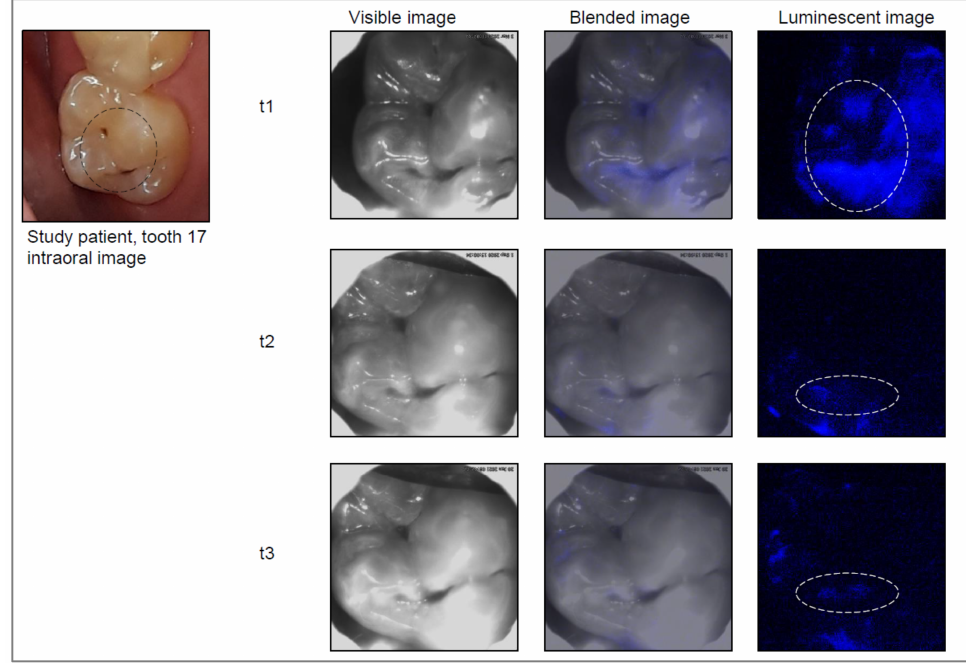
Figure 3. Example of a study tooth (upper right molar) with an active lesion at all visits. The bioluminescence signal was lower at t2 and t3 but still